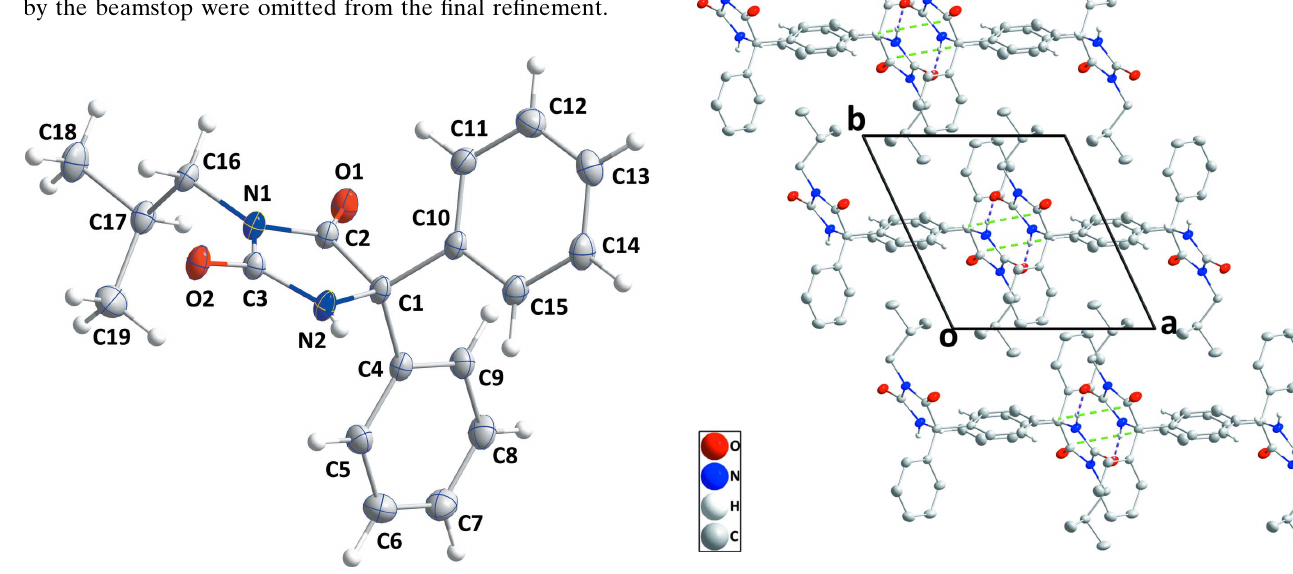
Figure 1 The title molecule with the labelling scheme and 50% probability